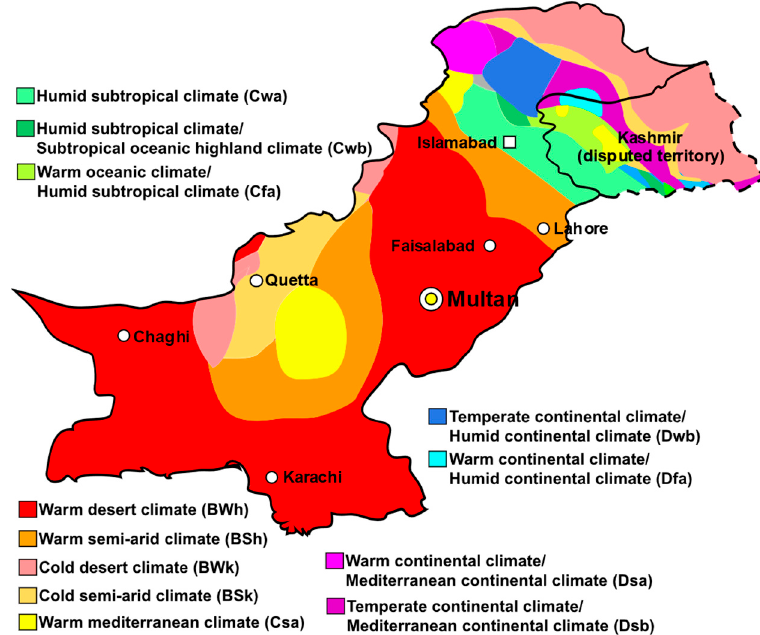
Figure 1. Köppen–Geiger climate classification map of Pakistan, reproduced from [47].